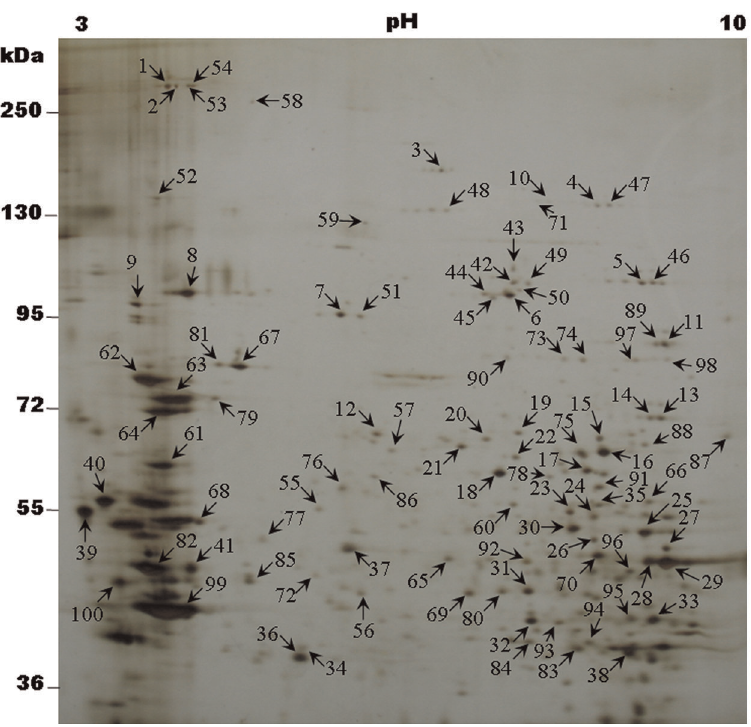
Figure 3. Representative example of 2D-gel of Chilosuppressalis larval midgut BBMV. BBMV were separated by 2D-gel electrophoresis followed by silver staining. Positions of molecular size markers (kDa) are indicated on the side of gel. Abundant protein spots were excised (numbers 1–100), digested, and subjected to mass spectrometry analysis for identification. Spot numbers correspond to the proteins listed in Table S3.